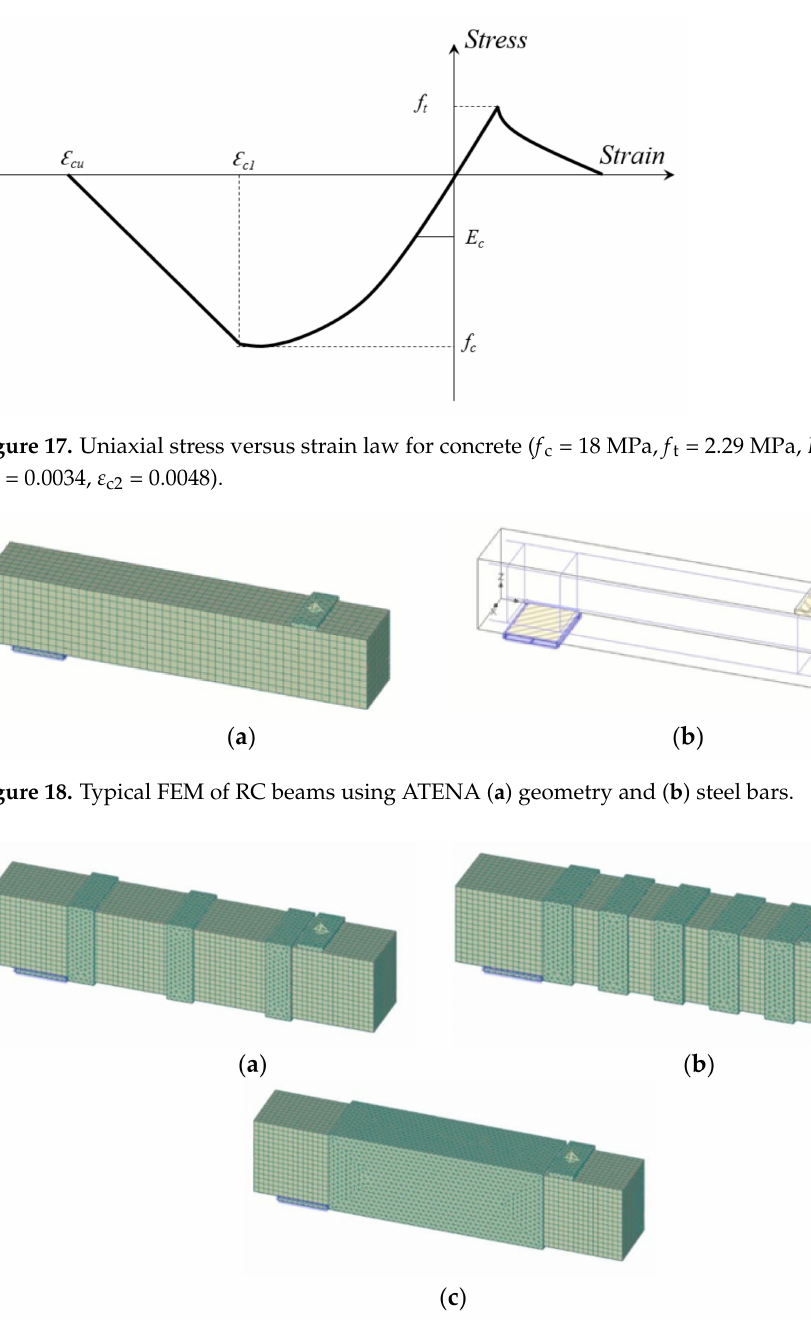
Figure 19. Finite element modelling of NFRRP composite strengthened RC beams ( a ) Type A configuration, ( b ) Type B configuration, ( c ) Type C